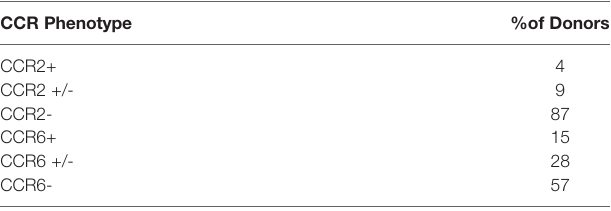
TABLE 2 | Expression of chemokine receptors from blood donors.